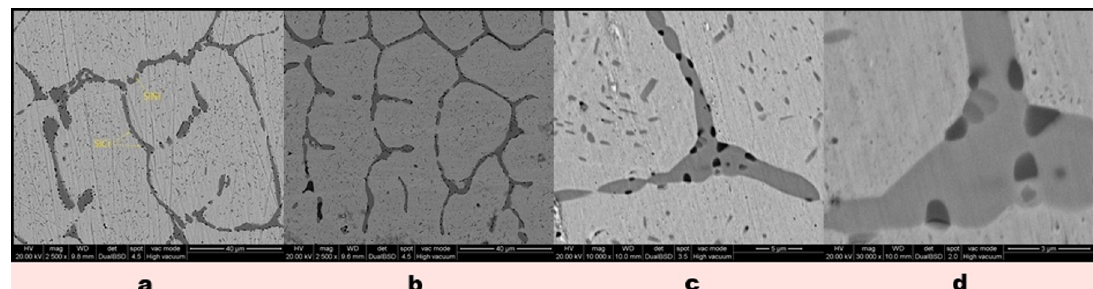
Figure 3. CuNiSiCr alloy. (A) as cast condition. (B) Annealed at 900 °C for 7.5 hours and quenched. (C) and (d) zoom of the region with second